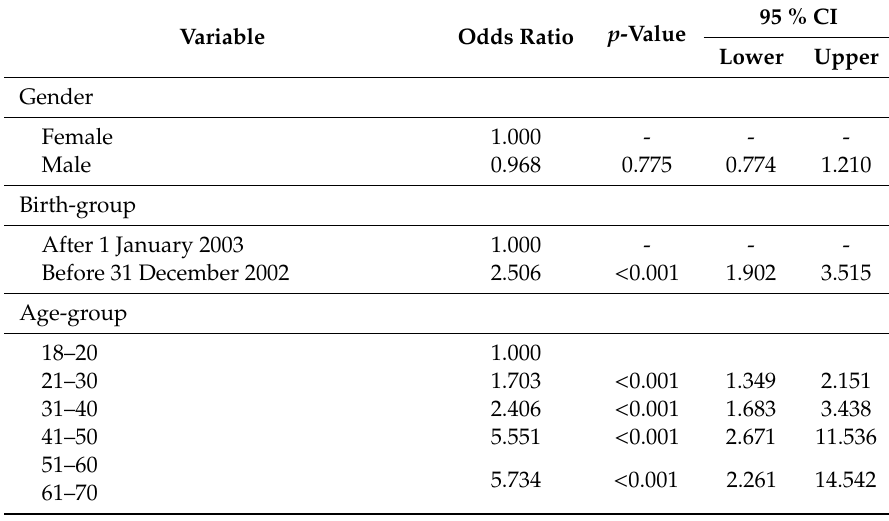
Table 3. Multiple logistic regression of immune status after national policy ( n =